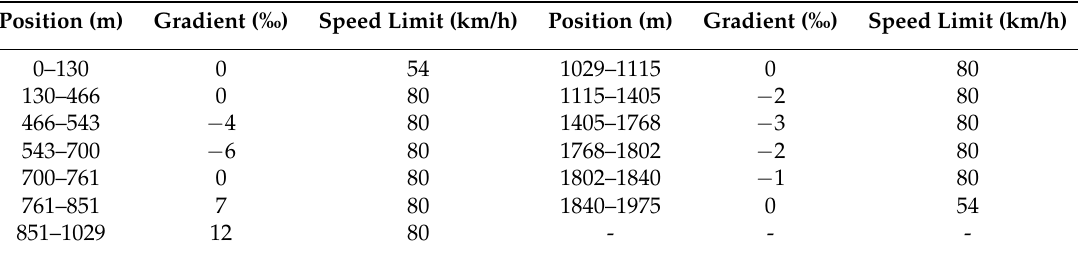
Table 3. Infrastructure data between Jiugong and Yizhuangqiao station. The negative gradient in the second column means downhill gradients.